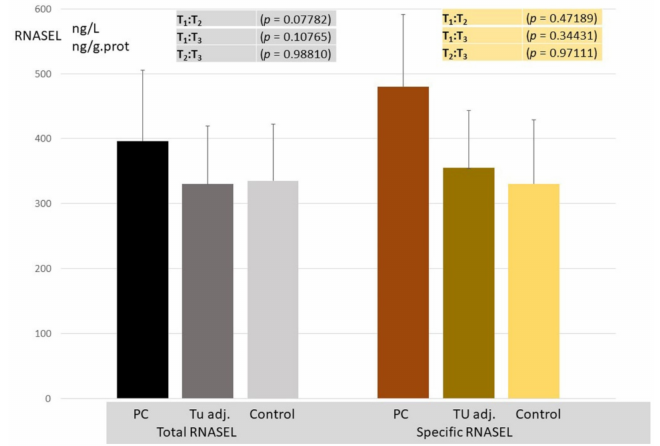
Figure 4. RNASEL total (ng/L) and specific (ng/g.prot) expression level in PC, tumor-adjacent, and control healthy